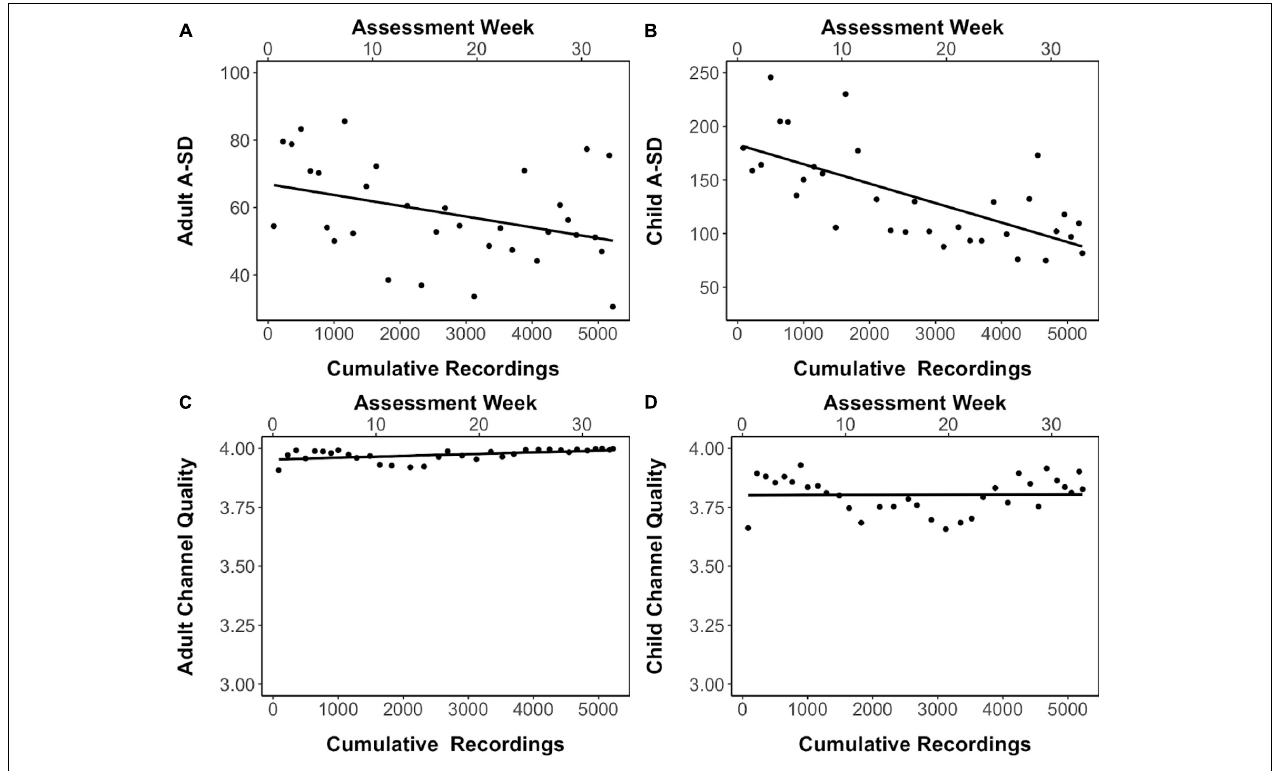
FIGURE 4 | Signal quality in eyes-closed resting-state EEG recordings. (A,B) The standard deviation of the amplitude of the EEG signal (A_SD) in adults and children respectively across data collection period and increased device usage. (C,D) The channel quality across data collection period and increased device usage in adults and children respectively. Linear trendline is